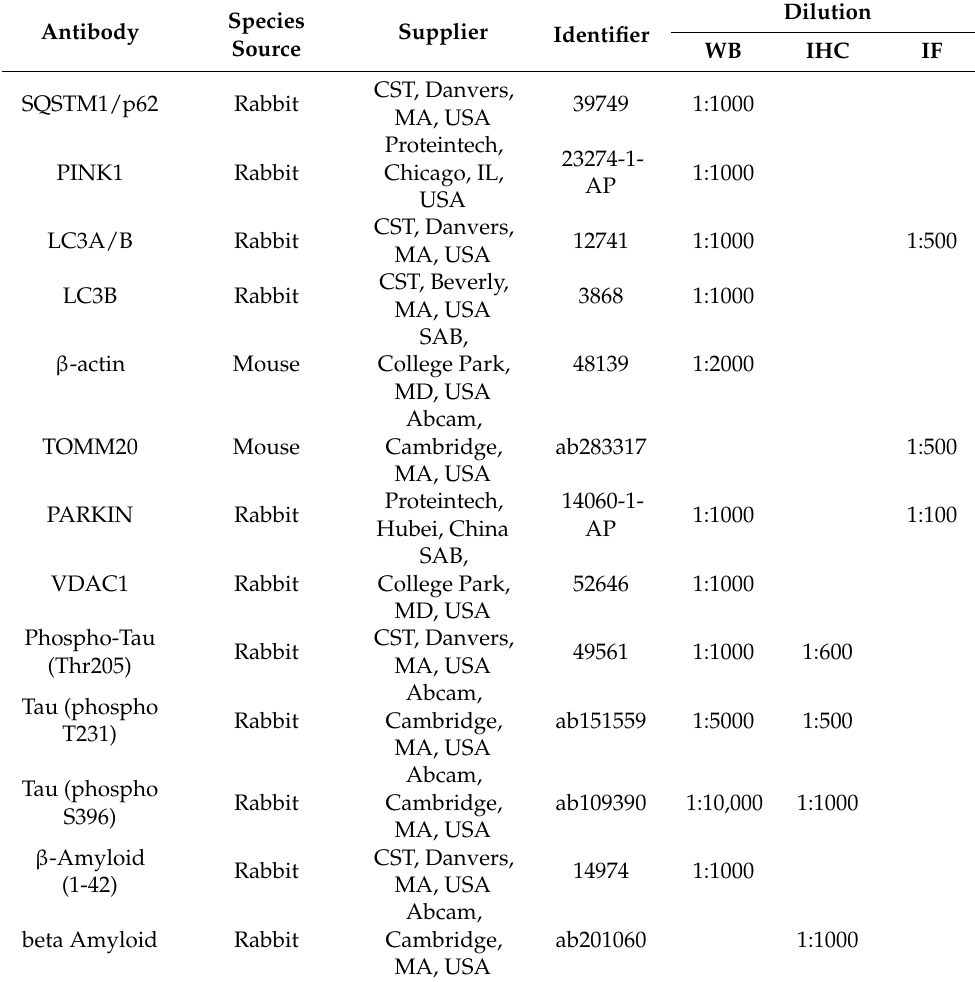
Table 1. The detailed antibody